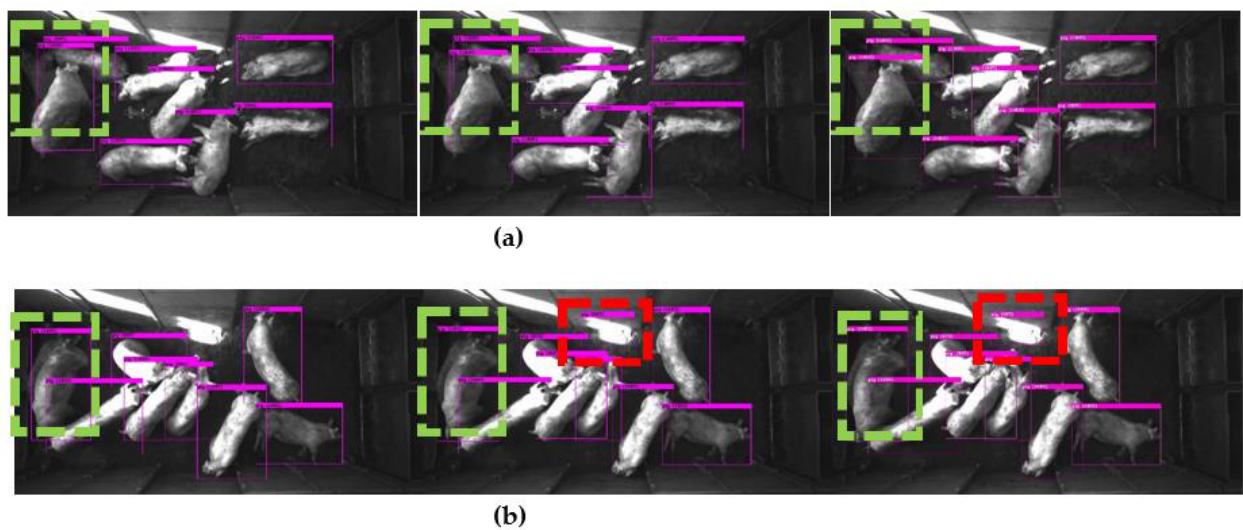
Figure 8. Failure cases ( left : model A, center : model B, right : EnsemblePigDet). ( a ) Cases of missing pigs in single model. ( b ) Cases of missing and false pigs in ensemble model.